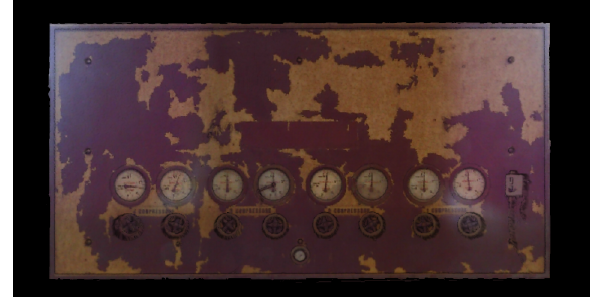
Figure 14. View of an extract of a control panel from global